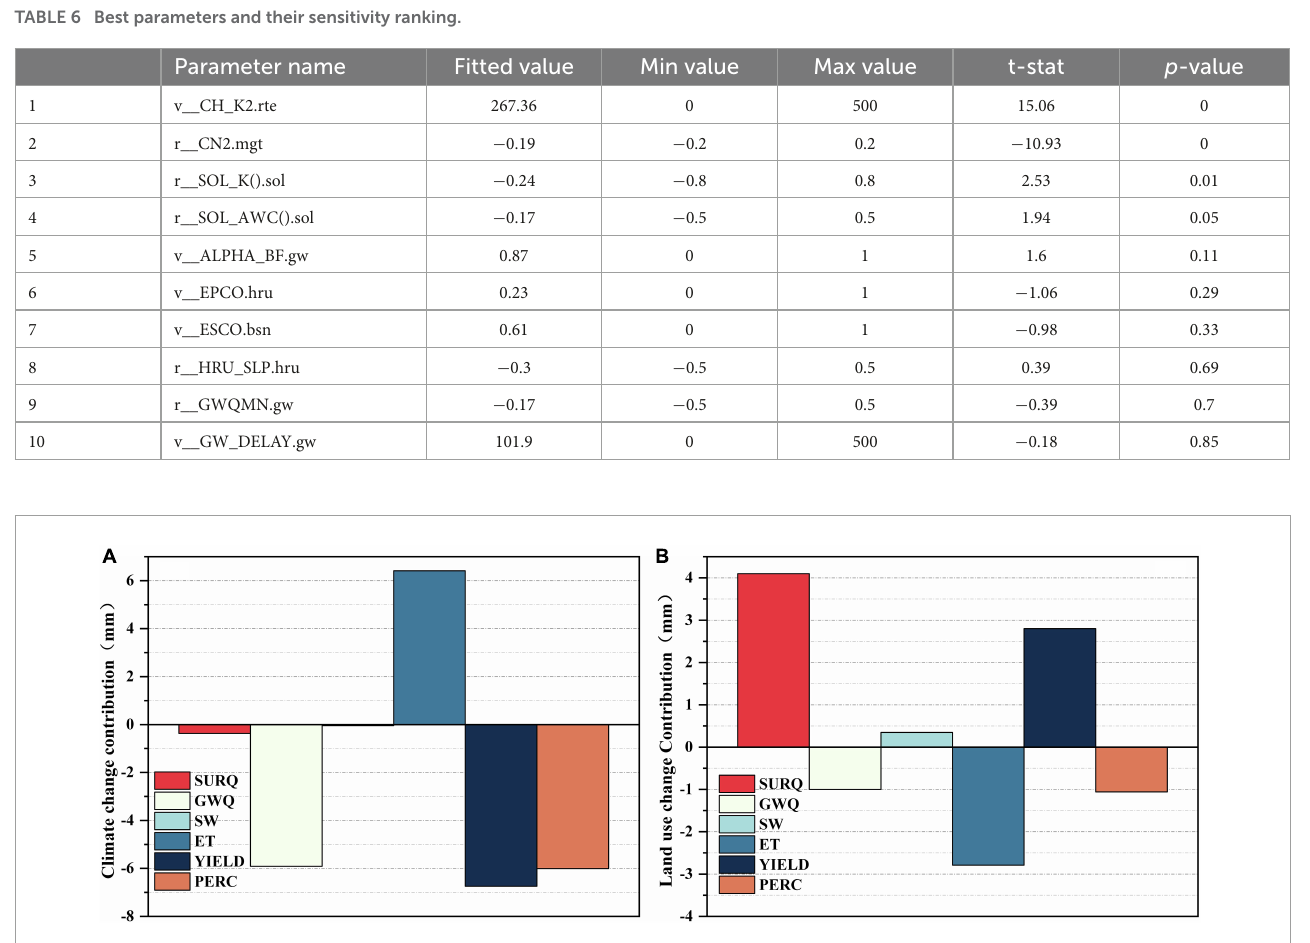
FIGURE9 Contribution of (A) climate change and (B) LUCC to key hydrological components. SURQ represents surface runoff, GW represents underground runoff, SW represents soil moisture, YIELD represents water yield, PERC represents infiltration; ET represents evapotranspiration.